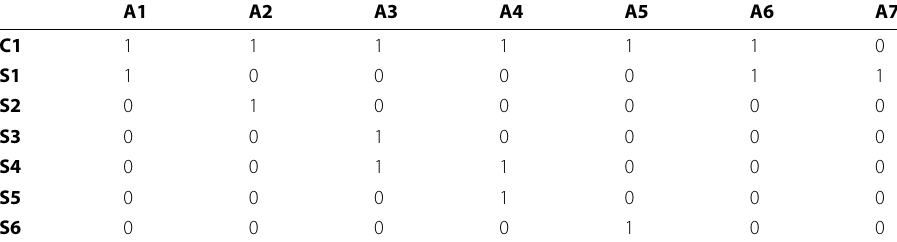
Table 2 Connectivity Matrix of Transaction Graph T1. Each column represents an account vertex. Each row represents a company vertex. Numbers are the number of time a transaction created an edge between the two vertices A1 A2 A3 A4 A5 A6 A7 C1 1 1 1 1 1 0 S1 1 0 0 0 S2 0 S3 0 0 1 0